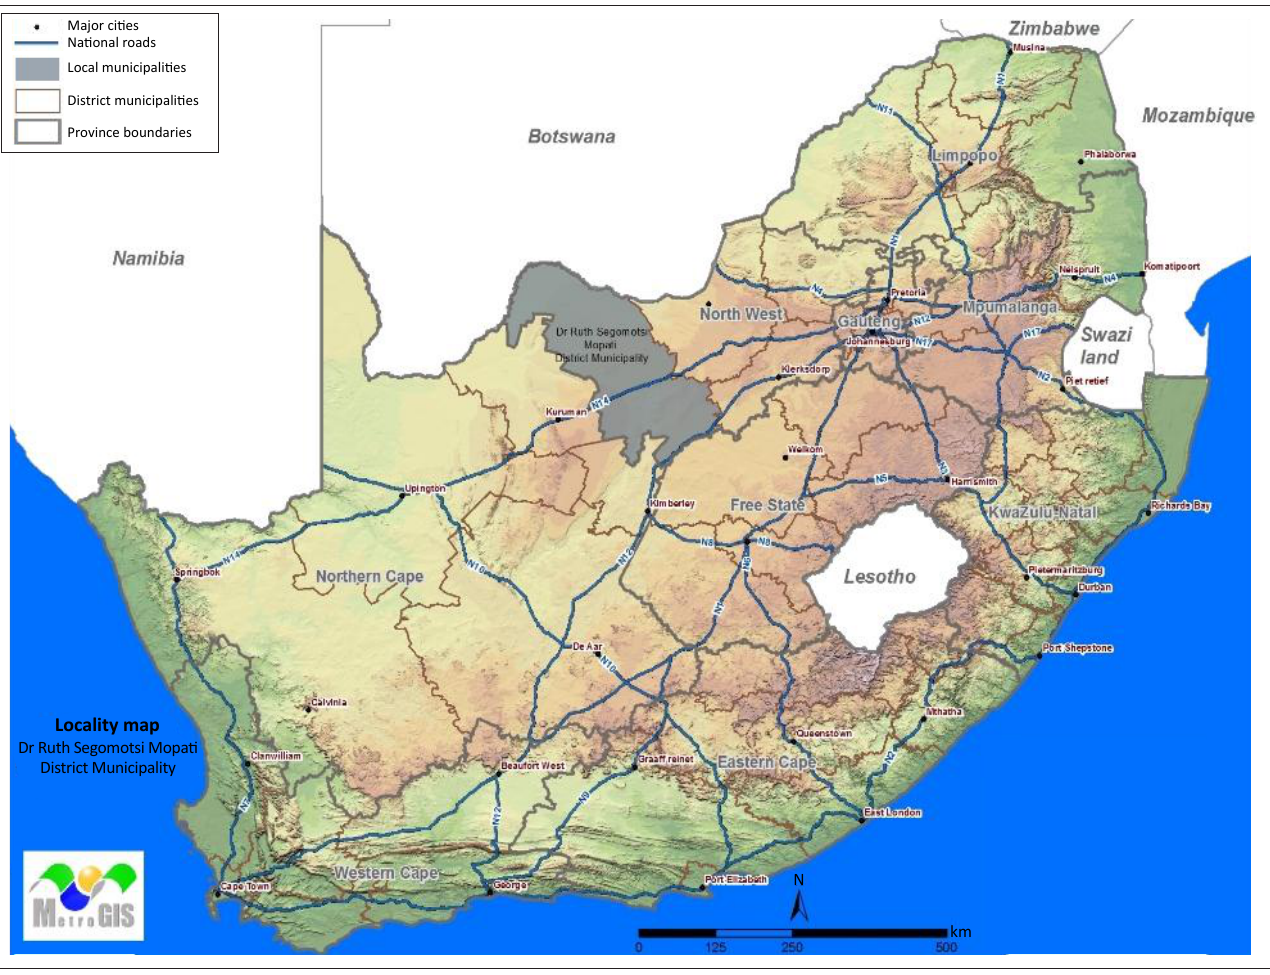
Source : MetroGis (Pty) Ltd. Source : MetroGis (Pty) Ltd. FIGURE 1 : Locality map of the Dr Ruth Segomotsi Mompati District Municipality. Figure 1 : Locality map of the Dr Ruth Segomotsi Mompati District Municipality. Figure 1 : Locality map of the Dr Ruth Segomotsi Mompati District Municipality. Source : MetroGis (Pty) Ltd. Figure 1 : Locality map of the Dr Ruth Segomotsi Mompati District Municipality.